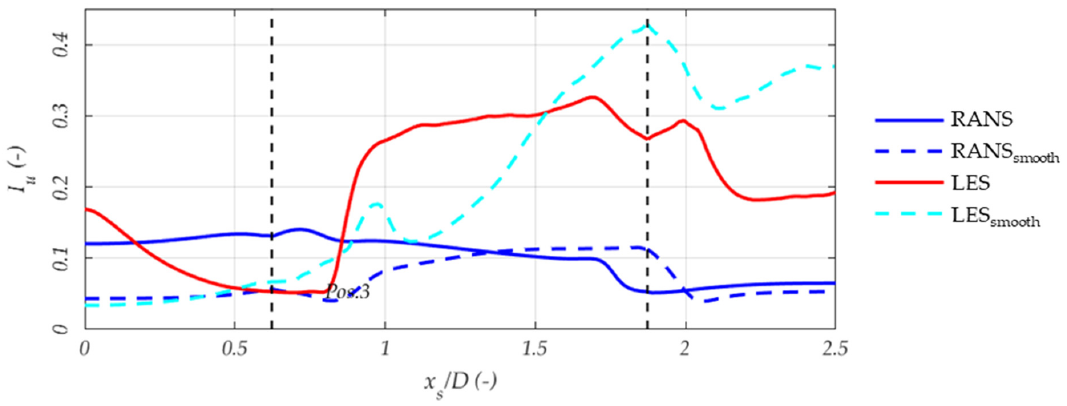
Figure 17. Pedestrian level prediction of the standard deviation of the horizontal wind speed. x S represents the pedestrian path abscissa shown in Figure 2.